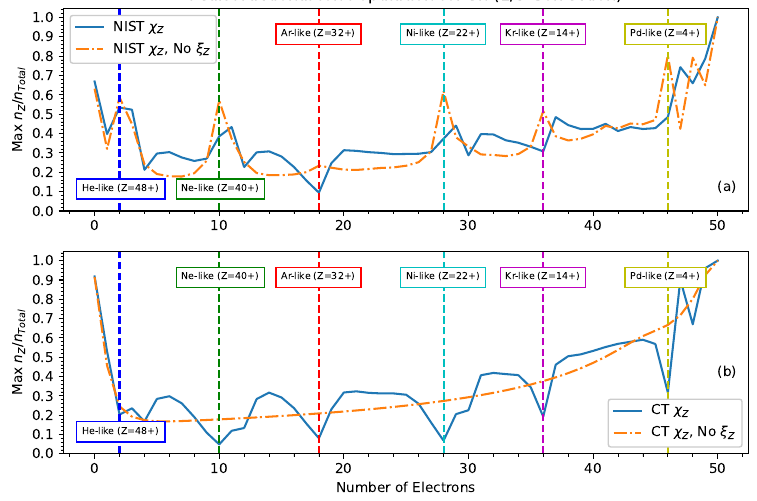
Figure 2. Plots of the peak fractional ion population for Sn calculated with the standard CR model, using Equation (3) (solid lines) and the standard CR model without the ξ Two different χ s were used, the NIST values [20] ( a ) and the estimated CT values from Equation (7) Z ( b ). The vertical lines mark noble gas configurations and configurations whose outermost subshell was a filled n d 10